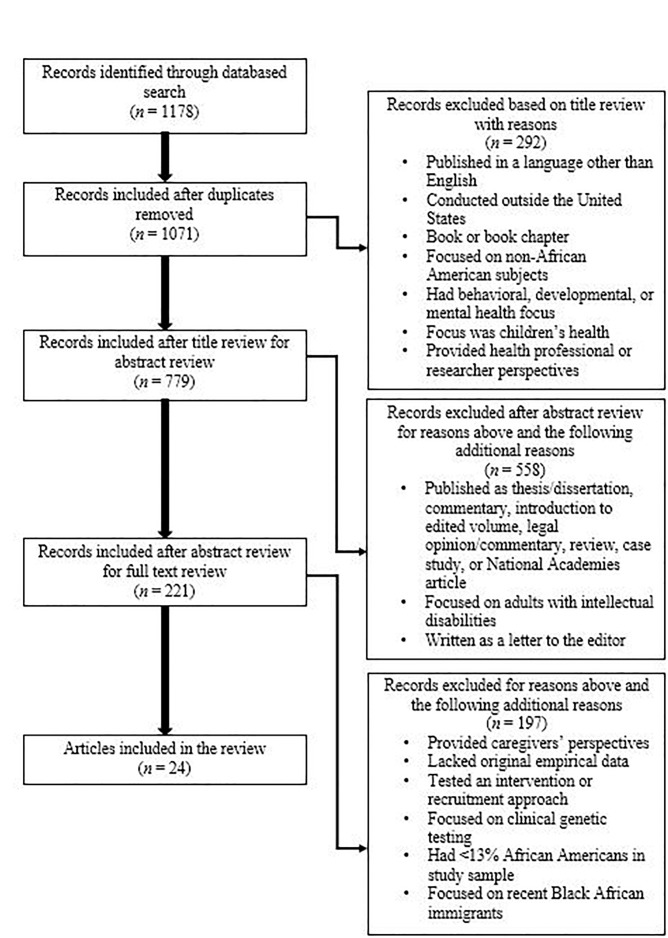
Exclusion process.